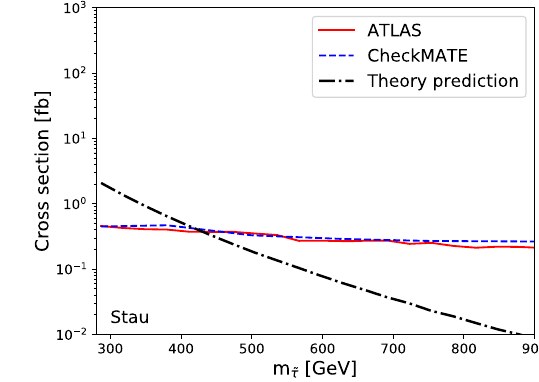
Fig. 4 Validation of the HCP search – observed upper cross-section limits using the best expected signal region for chargino pair produc- tion (left) and stau pair production (right). ATLAS results are shown as